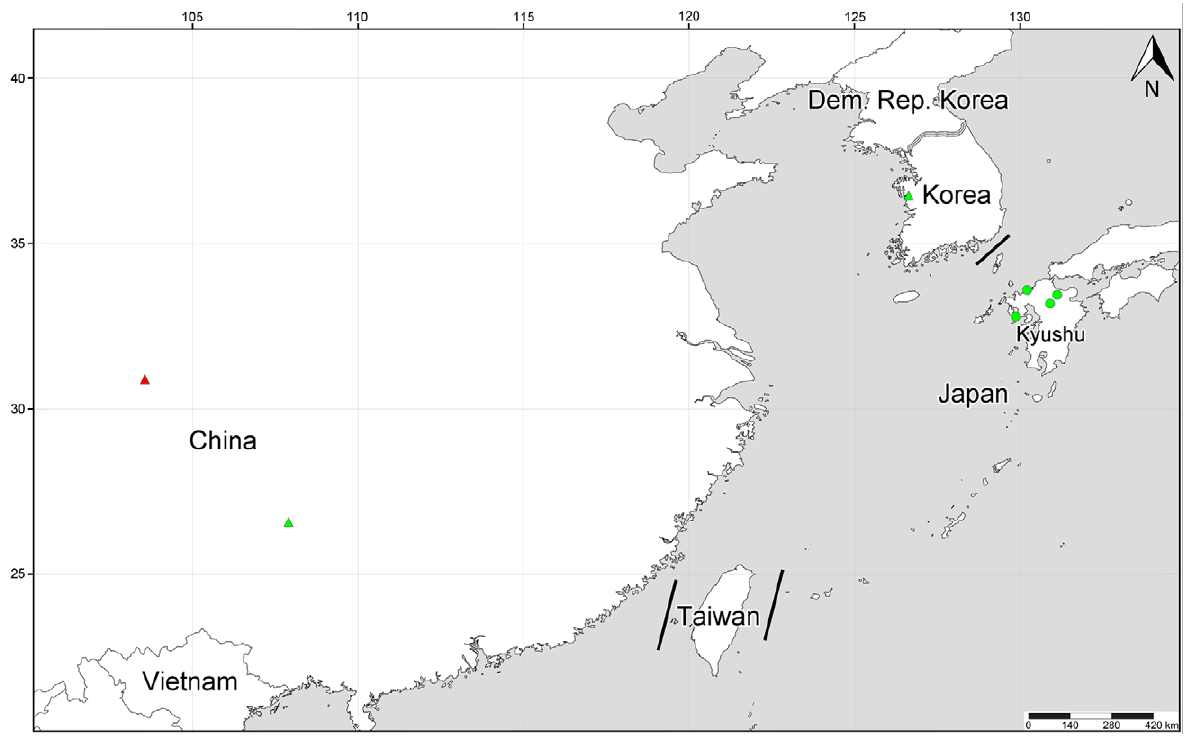
Figure 4. Collection sites of Alloeorhynchus reinhardi . Red icon = type locality; green icons = other localities. Circles = new records; tri- angles = known